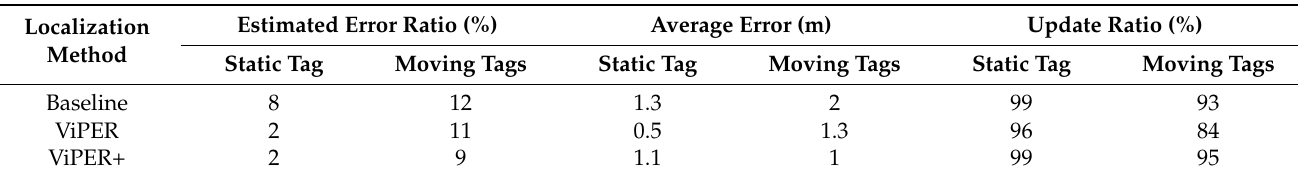
Table 5. The results of worker tracking for LOS scenario without blocking object.